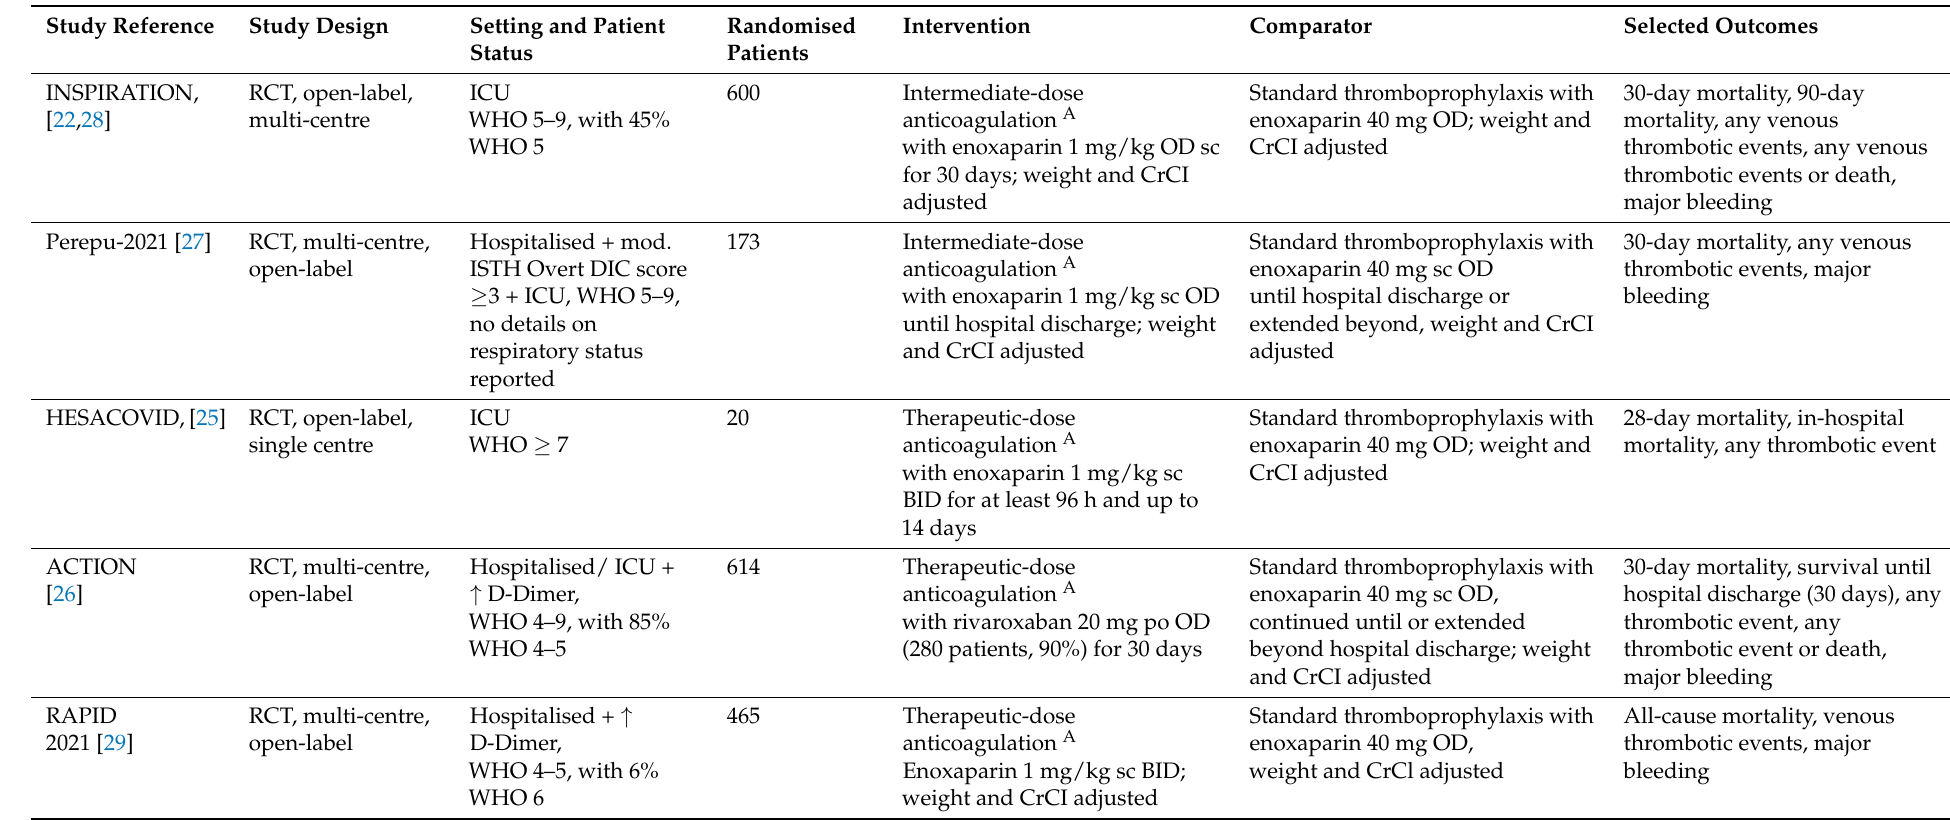
Table 1. Study characteristics of the eight included